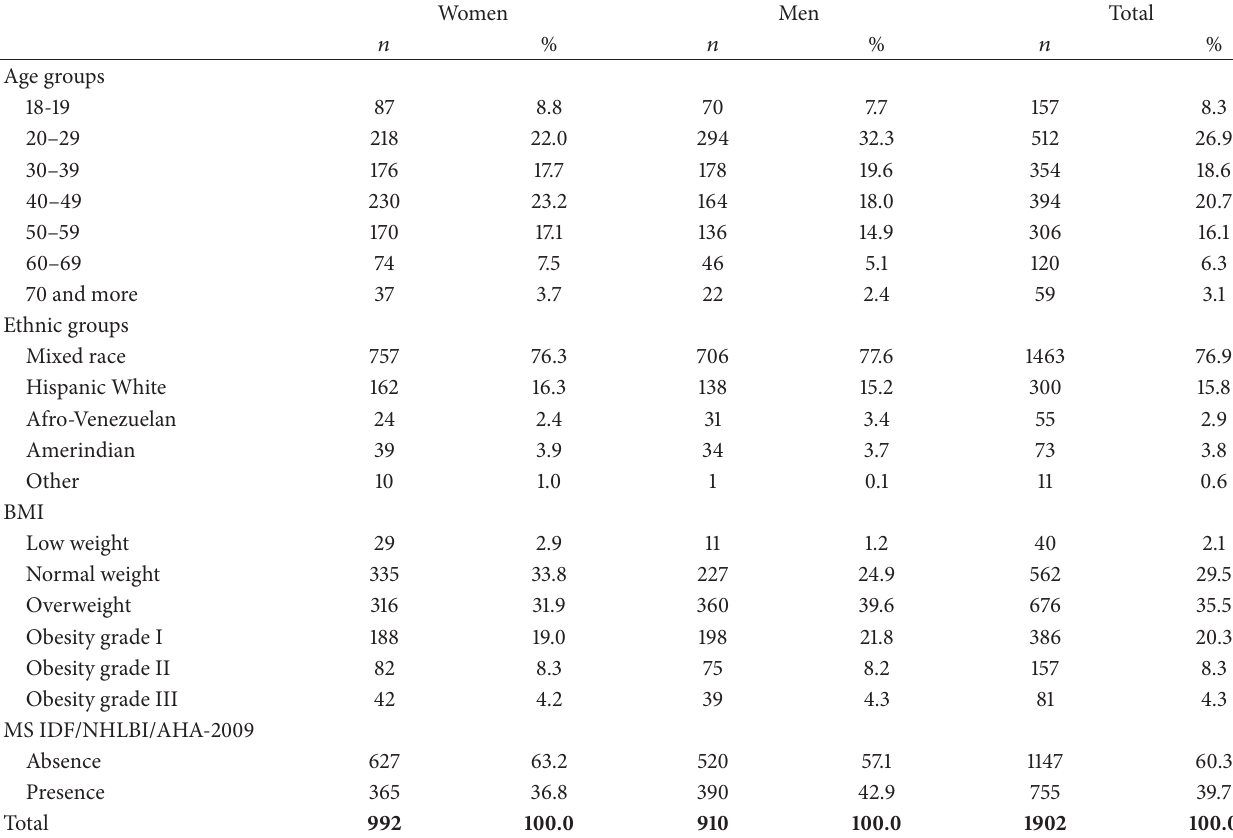
Table 2: General characteristics of the population from Maracaibo City Metabolic Syndrome Prevalence Study,